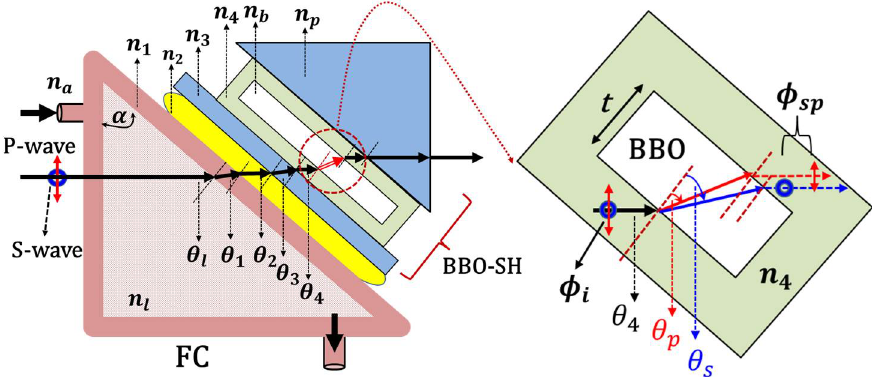
s-wave and the p -wave, respectively. There, n s and n p denote the RIs for the s-wave and p -wave, respectively. Based on Equations (1)–(3), the final θ s and θ p are obtained through Equations (4) and (5). The refracted angles θ s and θ p mainly depend on the values of n l and θ l . The values of n s and n p are 1.5496 and 1.6672 at the wavelength of 632.8 nm, respectively. The subtle angle difference causes different optical paths for both polarizations. The beam overlap between both polarizations causes interference depending on the phase delay from the optical path difference.